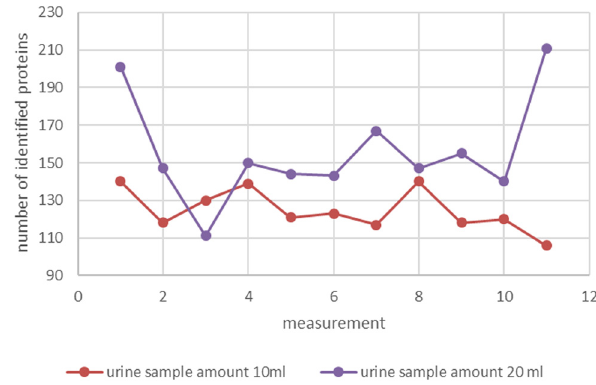
Figure 1: Comparison of proteins identi fi ed in relation to urine volume, 10 mL versus 20 mL; the number of proteins identi fi ed is an average of at least three